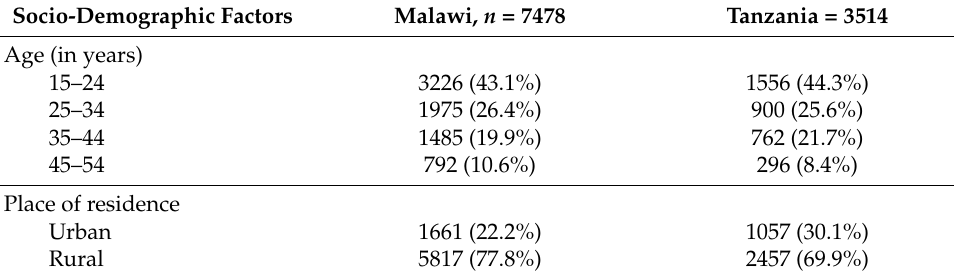
Table 2. Socio-demographic characteristics of the